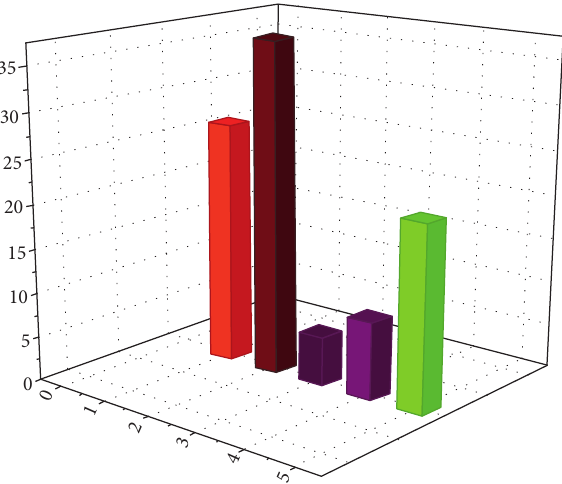
Figure 9: The sketch of employee in different positions.